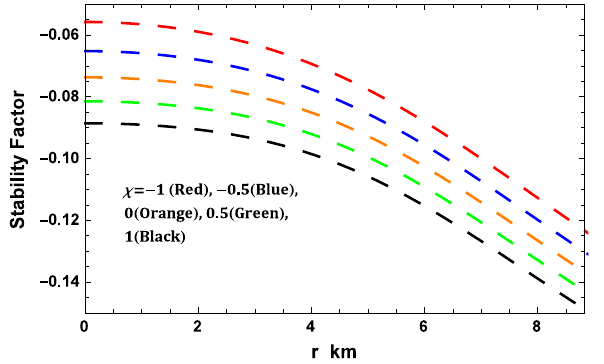
Fig. 12 Behavior of equation of state for SMC X-4 for M = 1 . 29 M (cid:9) , R = 8 . 831 km and b = 0 . 0031km − 2